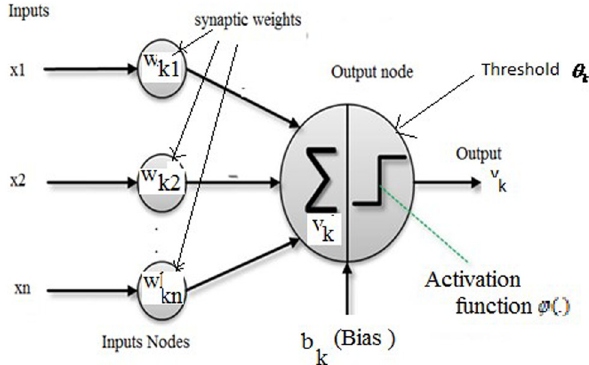
Figure 2: McCulloch – Pitts neuron model.